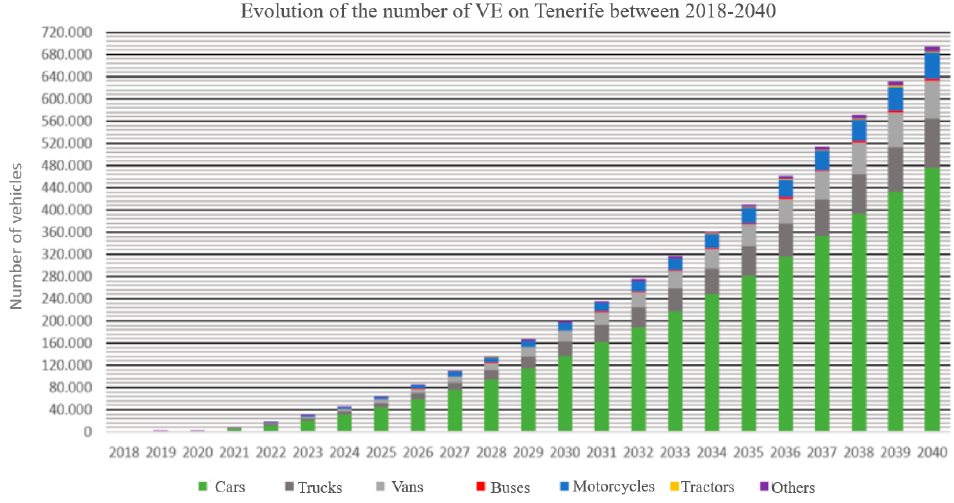
Figure 6. Evolution of the electric car fleet on the island of Tenerife between 2018–2040 [6]. In the case of private buildings, whether residential, commercial, or workplace, the number of parking spaces available was estimated based on data obtained from the